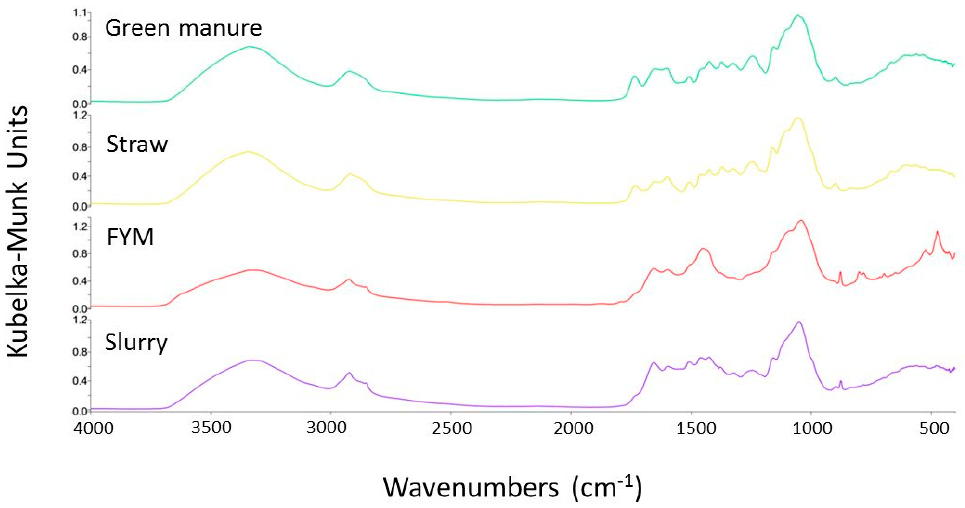
Figure 1. Diffuse reflectance infrared Fourier-transform spectroscopy (DRIFT) spectra of organic amendments. All spectra were maximized on the same Y -axis to facilitate the direct comparison of spectra. Green manure = mustard; straw = wheat straw; FYM = farmyard manure; slurry = cattle slurry.